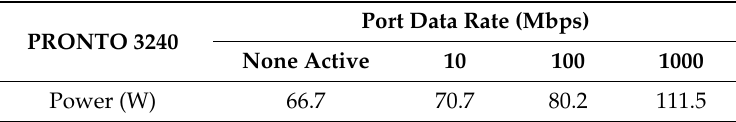
Table 2. Power specifications of the PRONTO 3240 switch